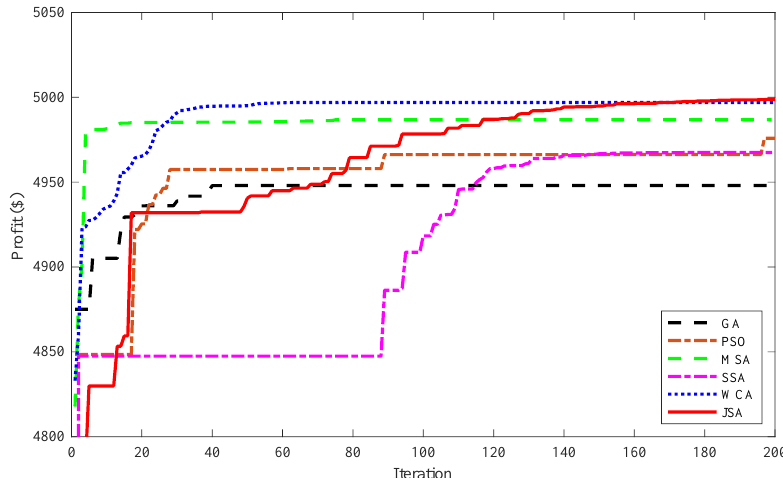
Figure 10. The process of finding the best profit implemented by applied algorithms for Case 2.